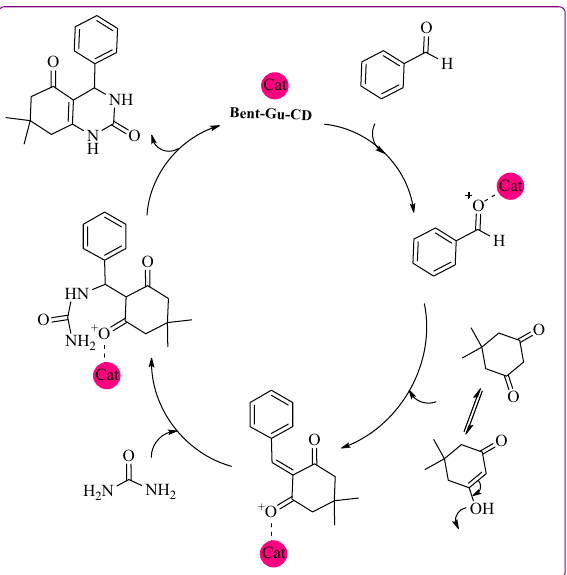
Figure 7. Proposed mechanism for the synthesis of octahydroquinazolinones.